Question: According to this chart, does the measure grow or shrink?
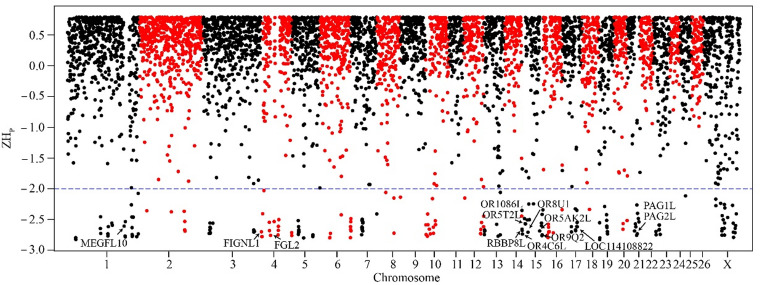
Answer: increasing